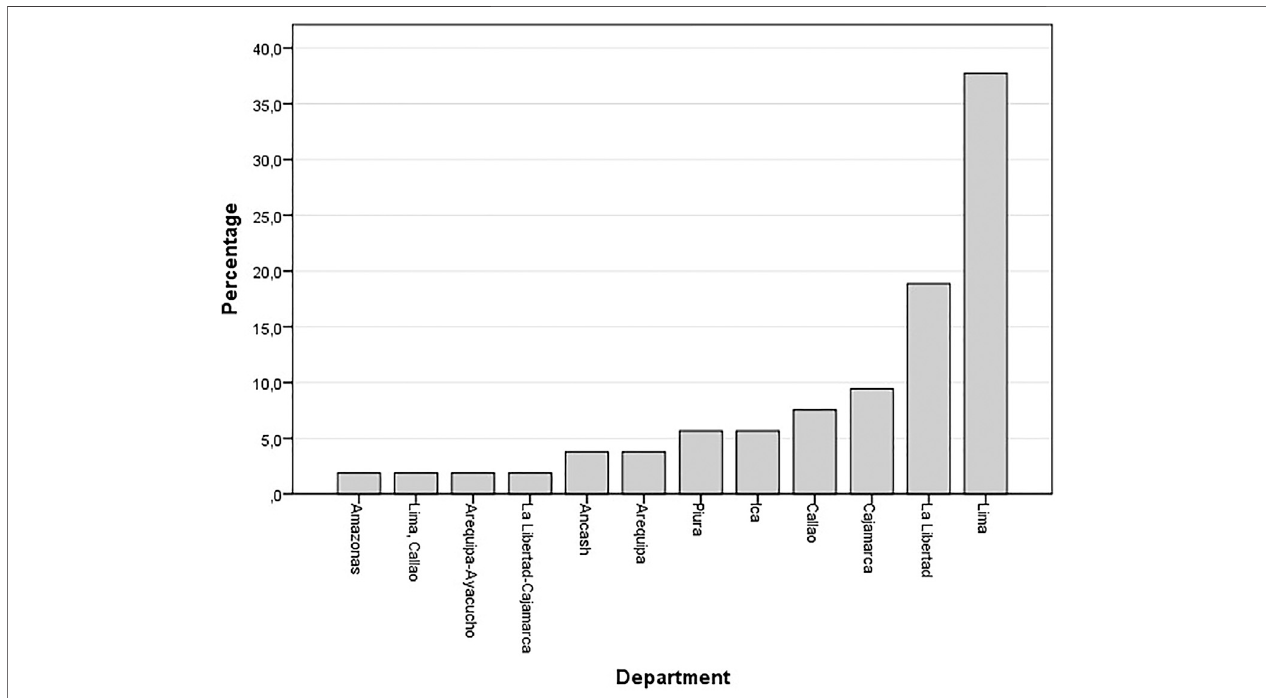
FIGURE 4 | Frequency of departments of Peru where studies on aquatic macroinvertebrates were conducted in arid and semi-arid ecosystems between years 1992 – 2020.